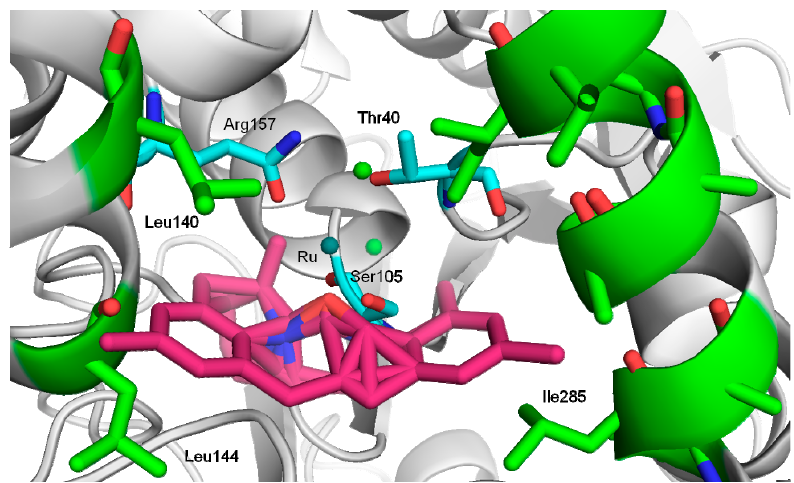
Figure 1. Hypothetical interaction between Hoveyda–Grubbs second-generation and CAL-B. The structure of CAL-B was obtained from the Protein Data Bank (pdb code: 1TCA) and the picture was created using Pymol v. 0.99. Hydrophobic residues (green). Hydrophilic residues (blue), Hoveyda–Grubbs second-generation (pink).